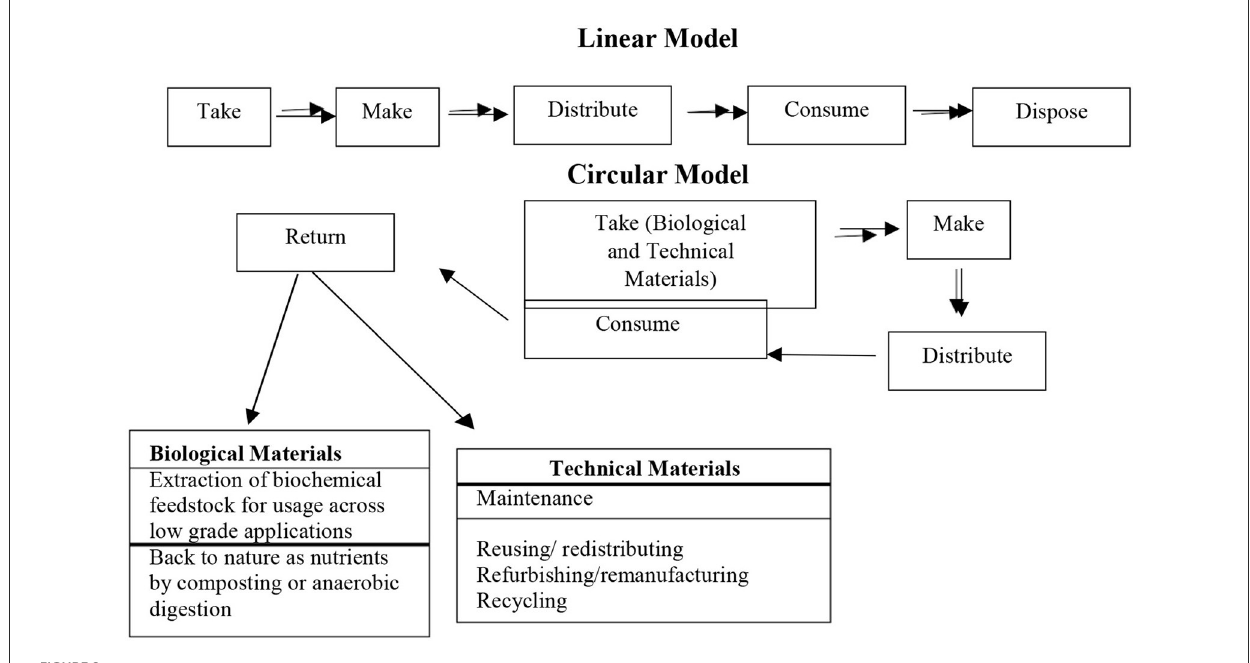
FIGURE2 Circular vs. Linear economy. Source: Adapted from De Angelis (2018, p. 21).